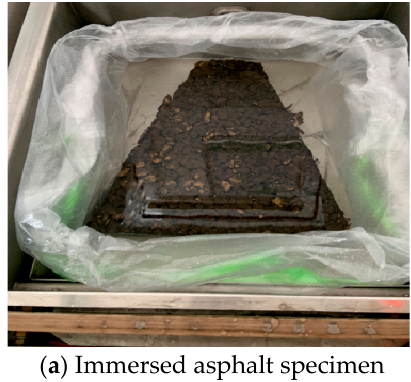
Figure 2. Specimens in the freeze–thaw cycle test.